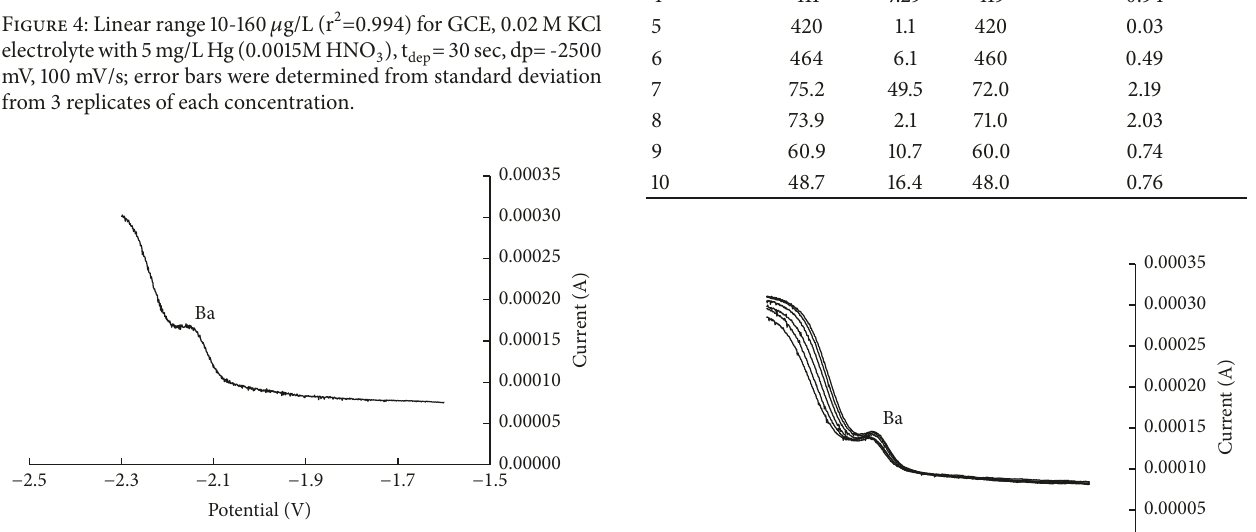
Figure 5: 1 𝜇 g/L barium concentration on GCE, 0.02 M KCl electrolyte with 5 mg/L Hg (0.0015M HNO 3 ), t dep = 120 sec, dp = - 2500 mV, and scan rate = 100 mV/s.